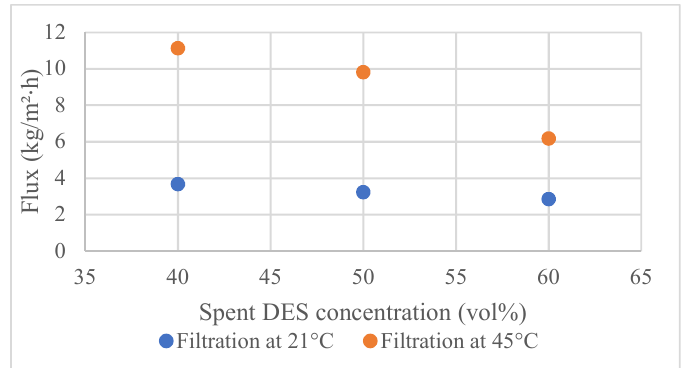
Figure 3. Effect of DES concentration in ethanol solution on the permeate flux through RC70PP at two temperatures—21 °C and 45 °C.